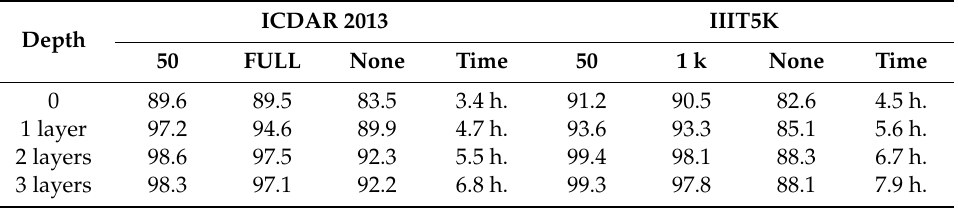
Table 6. Depth of BLSTM in EN and its recognition accuracies